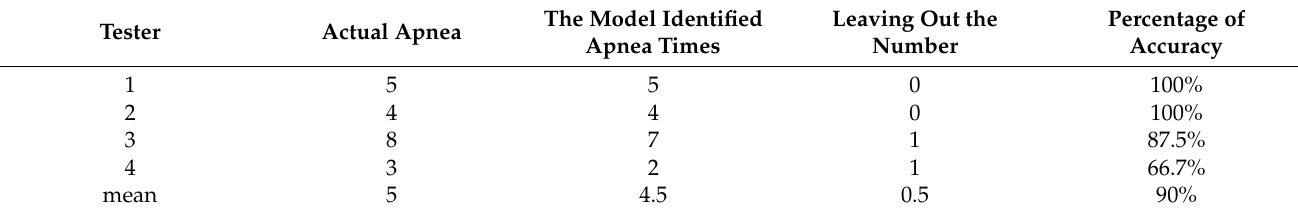
Table 3. The verification result statistics of test data of four